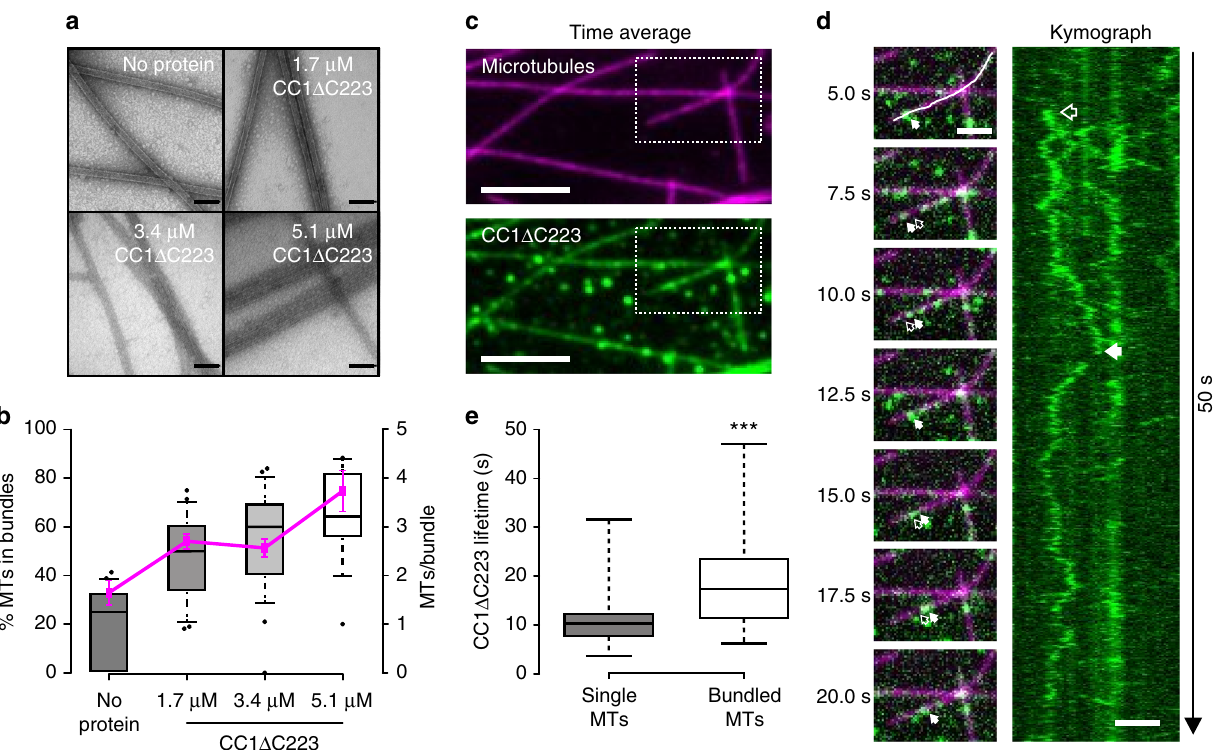
Fig. 2 The N-terminus of CC1 induces microtubule bundling and can diffuse along the microtubule lattice. a Transmission electron microscopy (TEM) of negatively stained taxol-stabilized microtubules after addition of increasing levels of 6xHis-CC1 Δ C223 during microtubule polymerization. Note that it is very dif fi cult to discern individual microtubules in the microtubule bundles after addition of ~3 µ M of CC1 Δ C223. Scale bars = 100 nm. b Quanti fi cation of the proportion of microtubules in bundles (left y -axis, box plots: Center lines show the medians; box limits indicate the 25th and 75th percentiles; whiskers extend to the 10th and 90th percentiles, outliers are represented by dots) and number of microtubules/bundle (right y -axis, magenta line: mean ± SEM) with increasing concentration of 6xHis-CC1 Δ C223 (quanti fi ed from images such as those in a ). c CF488A-labeled 6xHis-CC1 Δ C223 proteins (green) associated with surface-bound microtubules (magenta) in vitro. Scale bar = 5 µ m. d Time-series images (left panel) of CF488-labeled 6xHis-CC1 Δ C223 (green) diffusing along microtubules (magenta). Filled arrow = position in current frame, empty arrow = position in previous frame. Scale bar = 2 µ m. Representative kymograph (right panel) along solid line in left panel (top) showing diffusion of 6xHis-CC1 Δ C223 foci. Scale bar = 2 µ m. e 6xHis- CC1 Δ C223 lifetime on single versus bundled microtubules (box plots: Center lines show the medians; box limits indicate the 25th and 75th percentiles; whiskers extend to the minimum and maximum), n = 60 single and 37 bundled microtubules, *** p -value < 0.001, Welch ’ s unpaired t